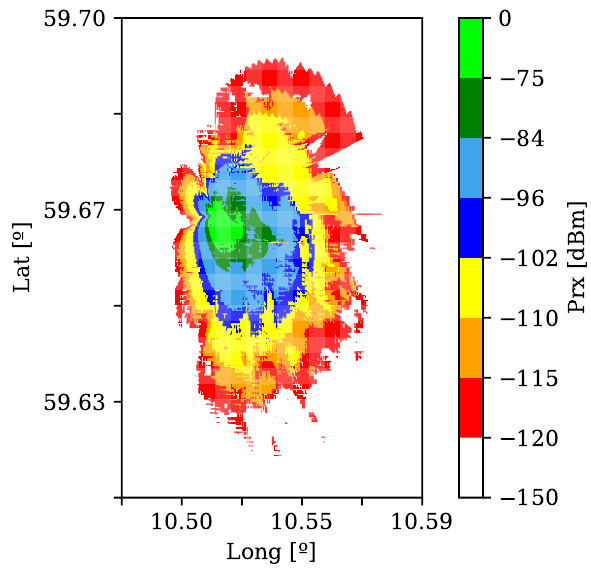
Figure 9. Coverage area extrapolated for a MIMO system with a BER of 10 − 2 and for the first iteration of